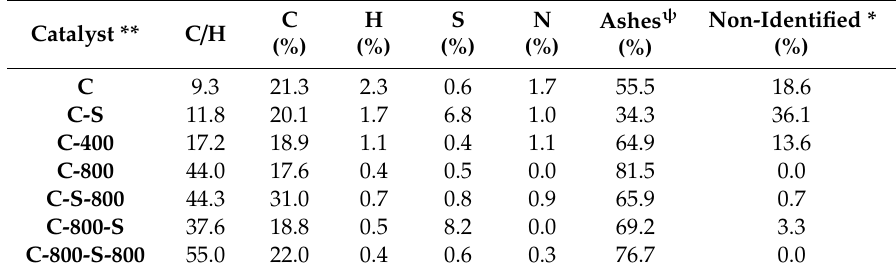
Elemental analysis, ashes and remaining residua of the materials determined by thermogravimetric